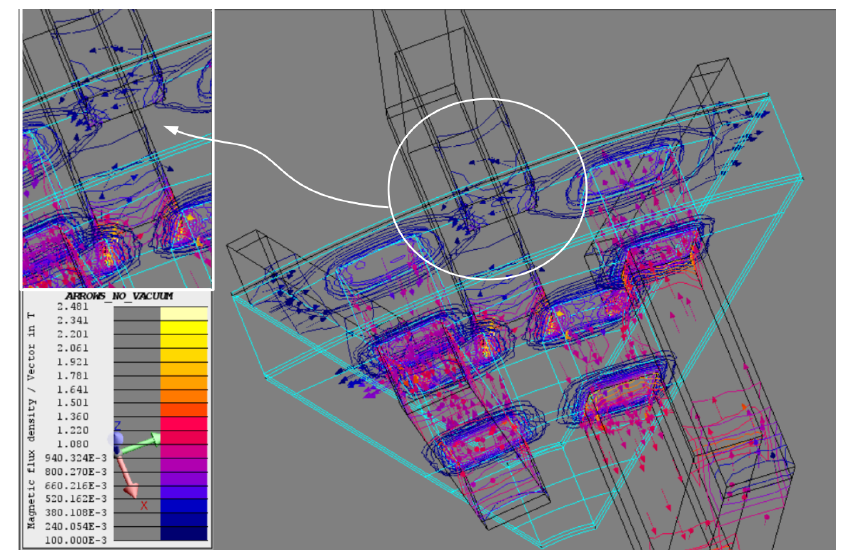
Figure 12. Axial coupling between